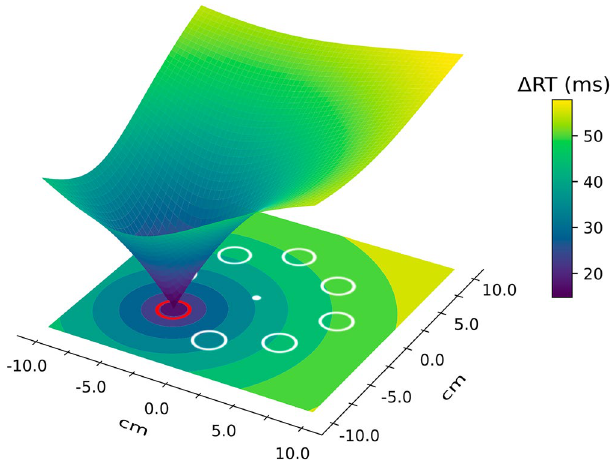
Figure 4. Visualization of the suppression map. The colours show the estimates of the spatial gradient of suppression. The high-probability location is indicated by the colour